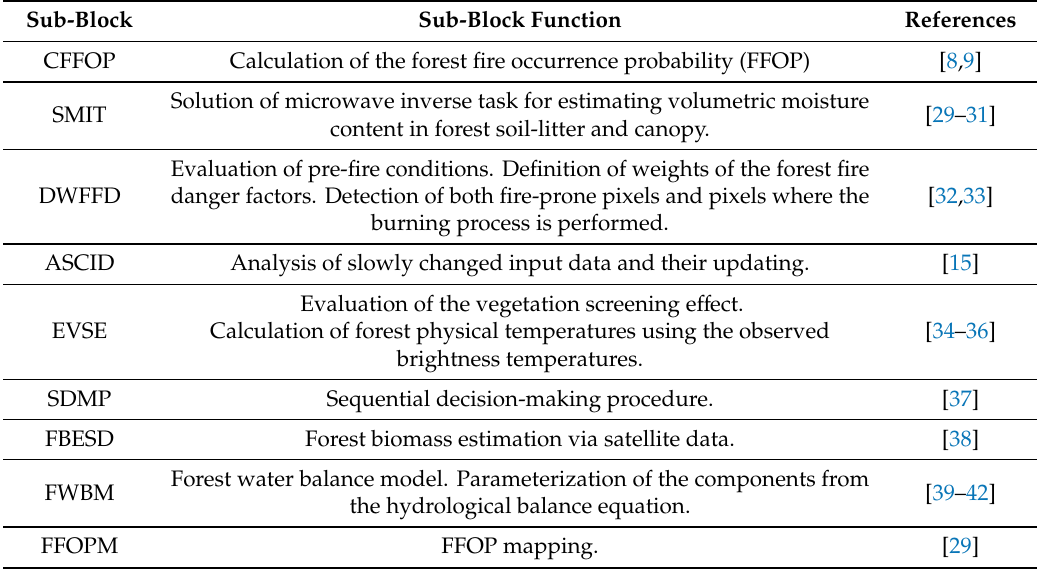
Table 2. The operational characteristics of the FFDPS items shown in Figure 2. Sub-Block Sub-Block Function CFFOP Calculation of the forest fire occurrence probability (FFOP) Solution of microwave inverse task for estimating volumetric moisture SMIT content in forest soil-litter and canopy. Evaluation of pre-fire conditions. Definition of weights of the forest fire DWFFD danger factors. Detection of both fire-prone pixels and pixels where the burning process is performed. ASCID Analysis of slowly changed input data and their updating. Evaluation of the vegetation screening e ff ect. EVSE Calculation of forest physical temperatures using the observed brightness temperatures. SDMP Sequential decision-making procedure. FBESD Forest biomass estimation via satellite data. Forest water balance model. Parameterization of the components from FWBM the hydrological balance equation. FFOPM FFOP